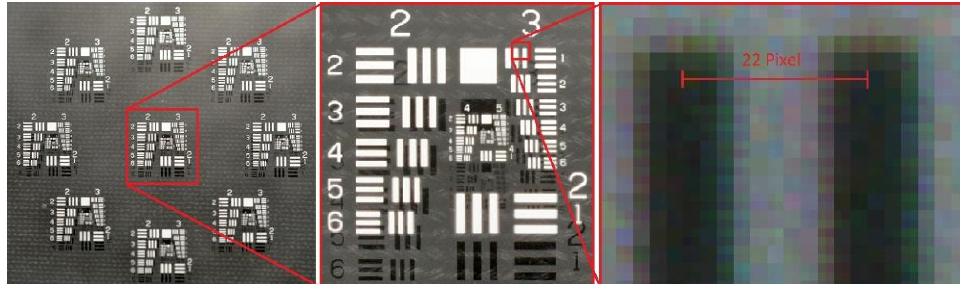
Figure 4. 1" × 3" Positive, USAF 1951 Wheel Target with Chromium lines on scintillating float glass. Each block contains a set of triple lines with decreasing size. The line distances and line width of each triplet are known, thus the smallest resolvable line triplet yields the camera or ion beam resolution. The right image shows a pair of lines with 22 pixels center to center distance. According to the specifications, there are eight pairs of lines per mm on this triplet. Therefore, a pair of lines has a distance of 0.125 mm and the pixels are calibrated to a spatial width of 5.68 µ m.